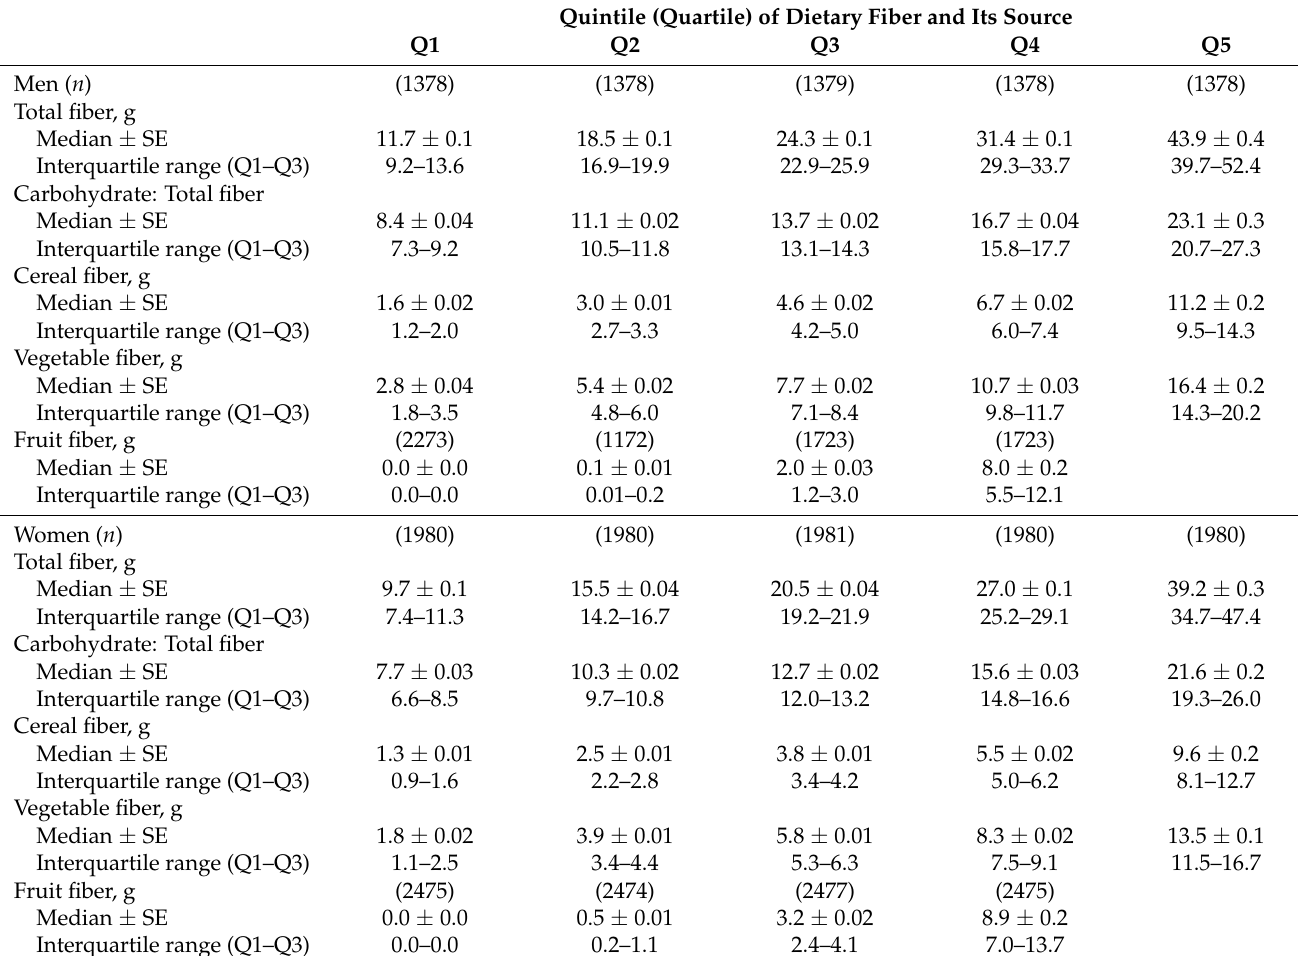
Table 2. Distribution of dietary fiber and its source by sex 1